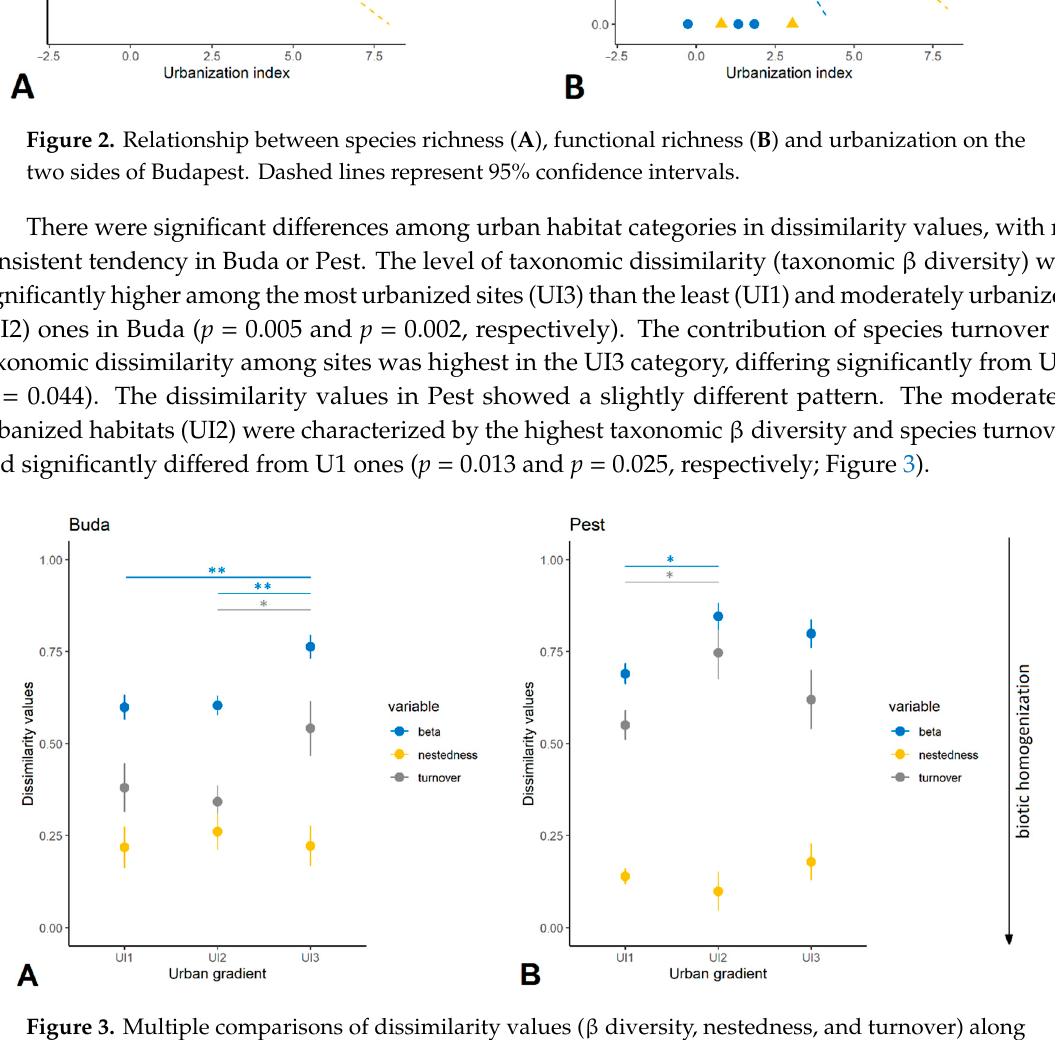
Figure 3. Multiple comparisons of dissimilarity values ( β diversity, nestedness, and turnover) along an urban gradient in Buda ( A ) and Pest ( B ). Abbreviations: UI1, least urbanized; UI2, moderately urbanized; UI3, highly urbanized. Statistical significance is determined at ** p < 0.01 and * p < 0.05.